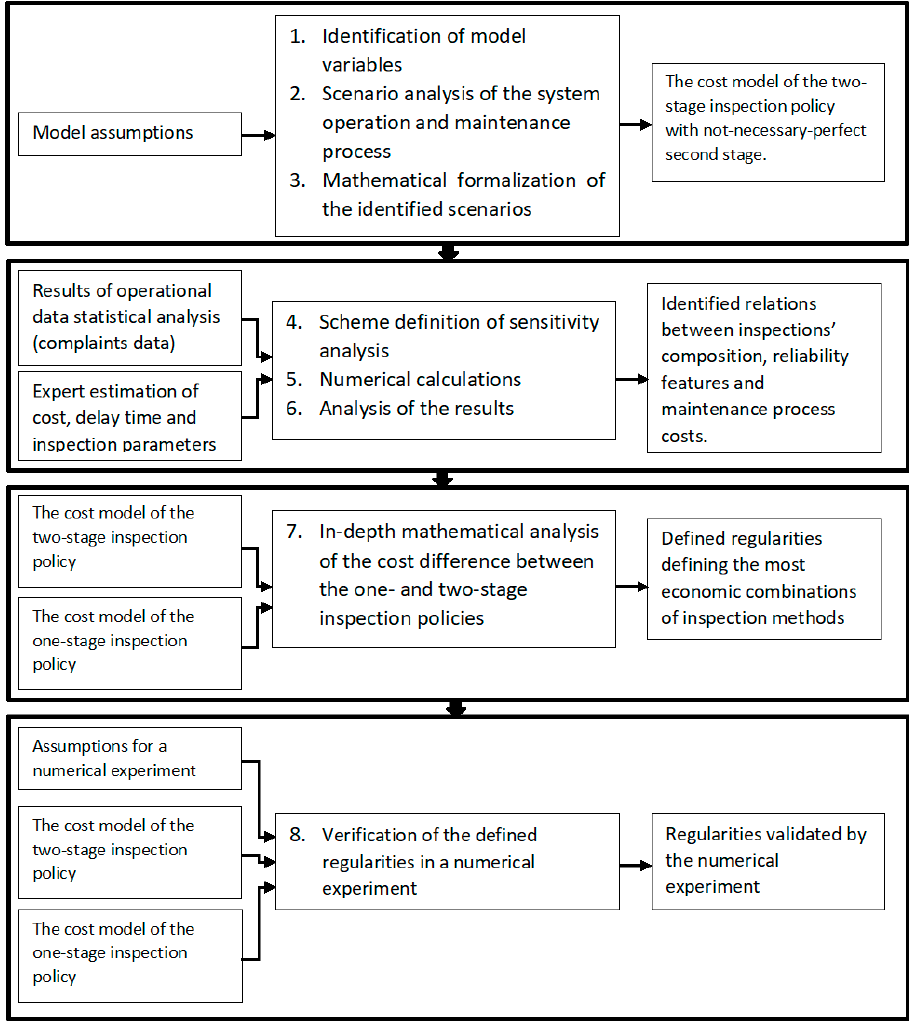
Figure 1. The methodology of the research